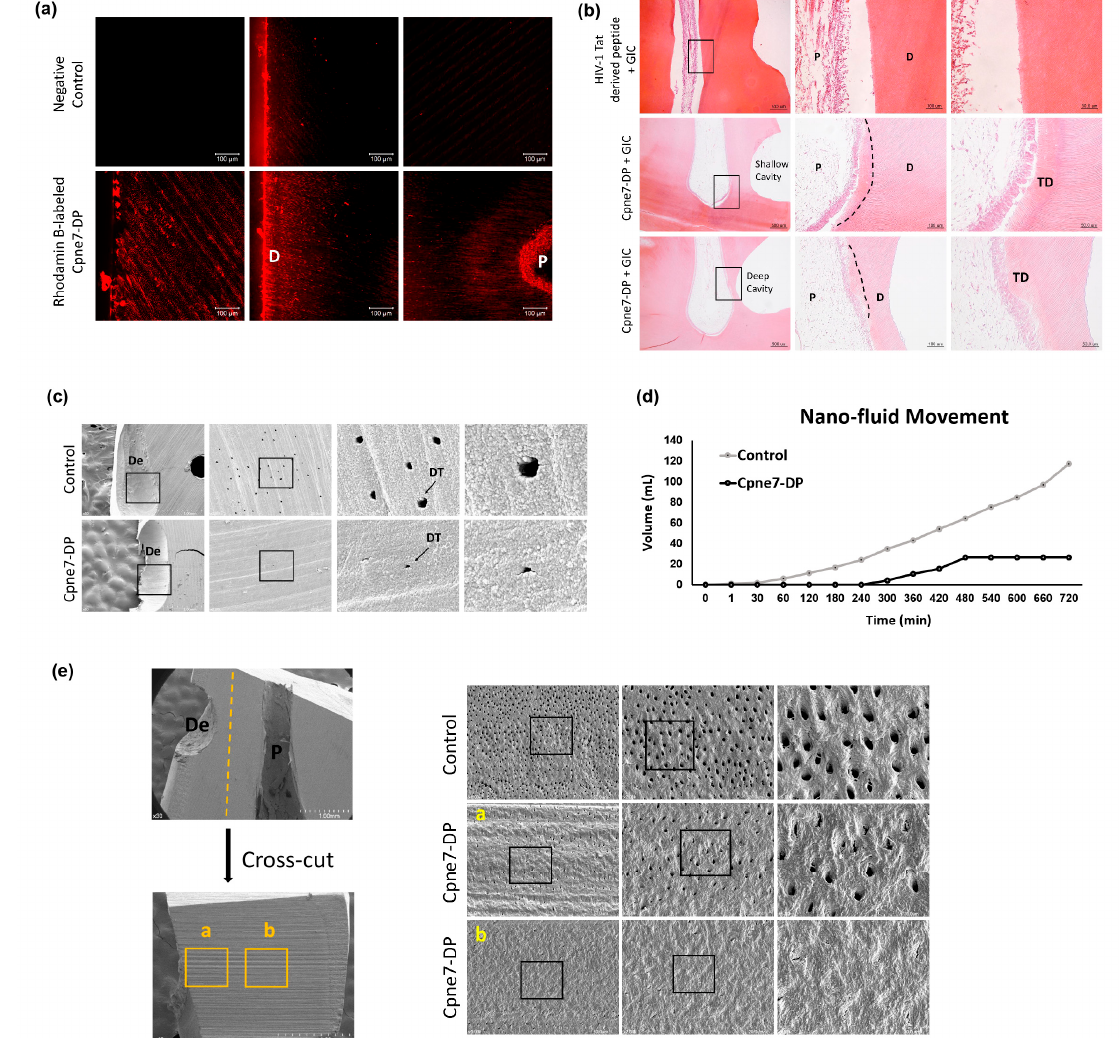
Figure 4. Cpne7-DP treatment induces the regeneration of tubular orthodentin in both dentin defect canine models, and promotes dentinal tubule occlusion by inducing peritubular dentin formation. ( a ) Evaluation of dentinal tubule penetration of Rhodamin B-labeled Cpne7-DP by using confocal laser scanning microscopy. ( b ) Histological analysis of dental pulp responses at the shallow cavity and deep cavity preparation areas treated with HIV-1 Tat-derived peptide (Control) or Cpne7-DP after 3 weeks by hematoxylin and eosin staining ( n = 12). Dashed lines indicate the remaining original dentin/newly formed dentin interfaces. ( c ) Scanning electron microscopic analysis of defect surfaces after removal of the filling materials. Arrows indicate the dentinal tubules. ( d ) Nano-fluid movement (microleakage) analysis. ( e ) Scanning electron microscopic analysis of cross-sectioned surface between the defect and the pulp space. Areas noted by a and b indicate sectioned surfaces underneath the unaffected part of the crown and underneath the defect, respectively. P, pulp; D, dentin; TD, newly formed tertiary dentin; OD, osteodentin; De, defect; DT, dentinal tubules.